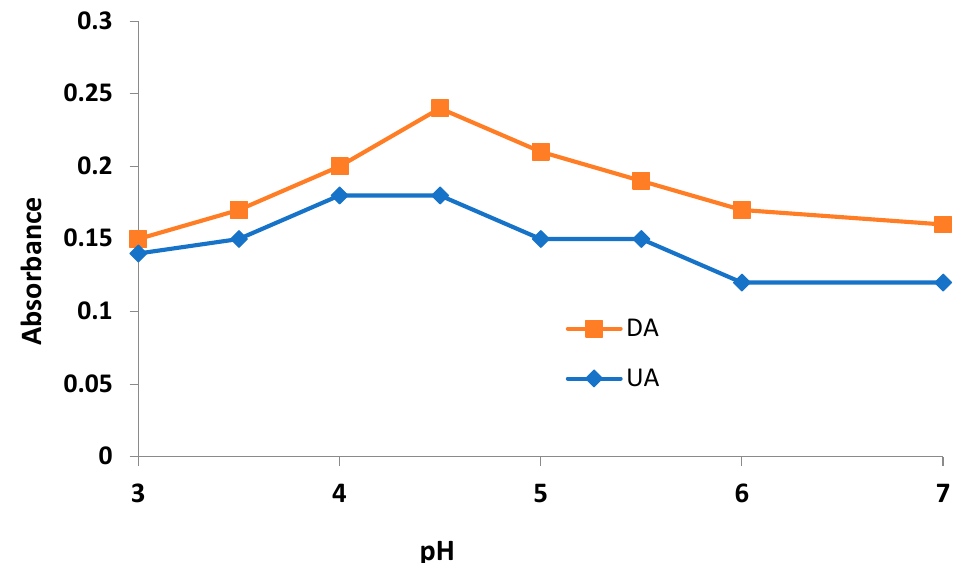
Figure 2. Effect of pH on absorbance variation of DA and UA.